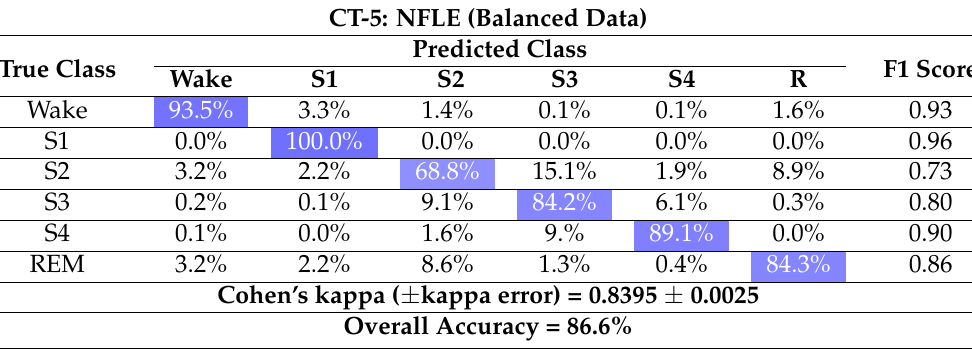
Table 18. Confusion matrix corresponding to sleep stage classification of Nocturnal frontal lobe epilepsy patients with balanced data using the EBT classifier with 10-fold